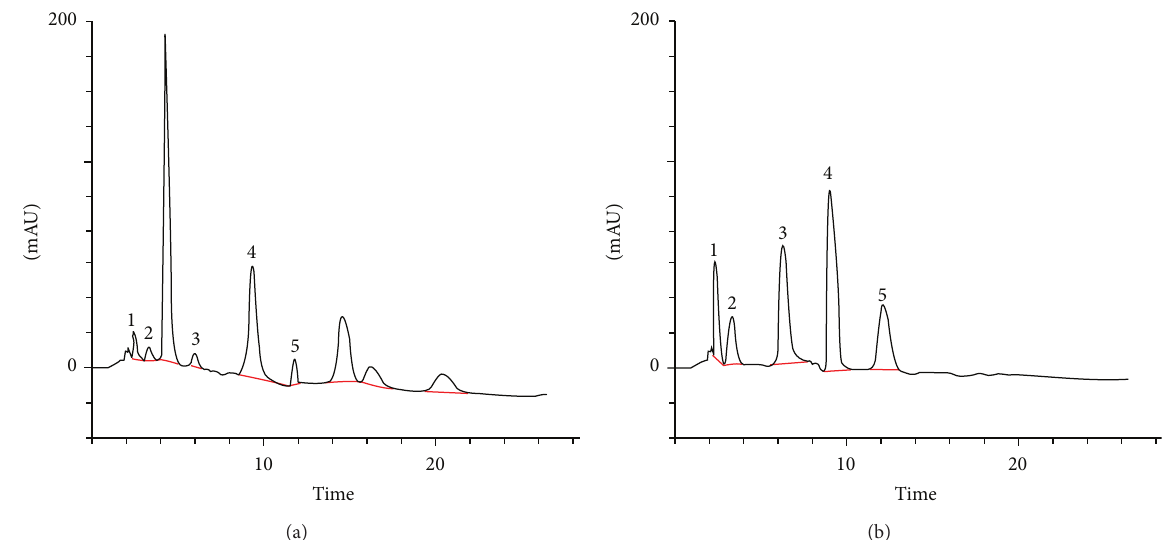
Figure 1: HPLC chromatogram of phenolic compounds from T. graminifolius 70% ethanolic extract of aerial part (a) and standard phenolic compounds mixture (b). Chromatogram identification: (1) gallic acid; (2) catechin; (3) caffeic acid; (4) 𝜌 -coumaric acid; (5) ferulic